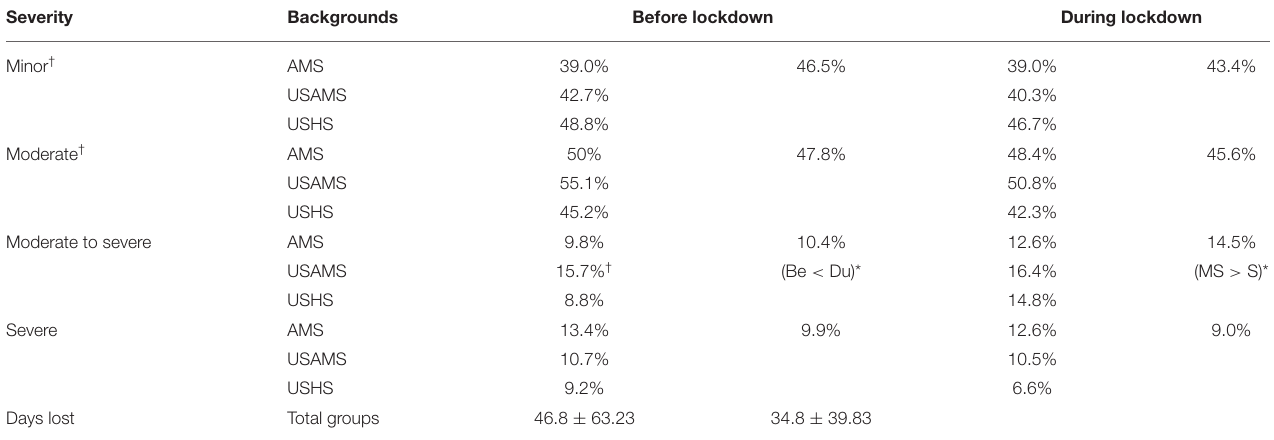
TABLE 3 | Injury severity in two periods (%).